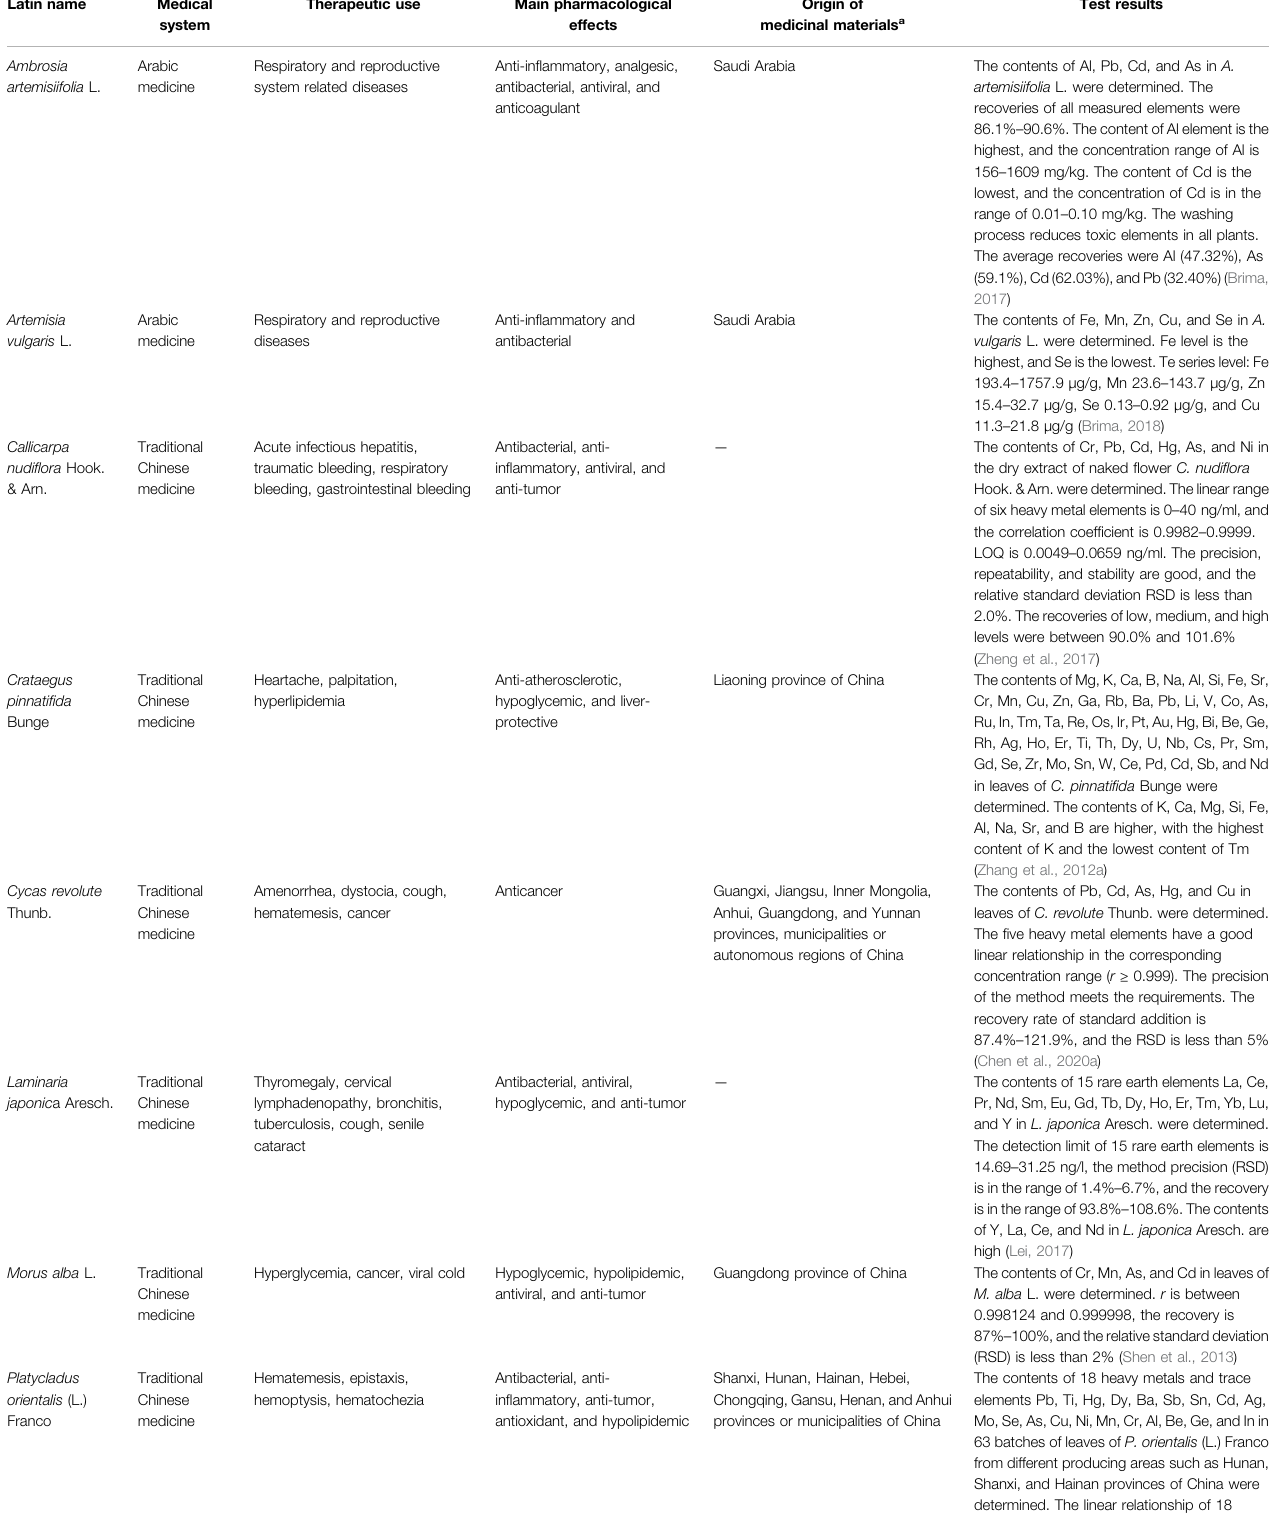
TABLE 3 | Application of ICP-MS in the determination of heavy metal elements in medicinal materials derived from the leaf of plants. Latin